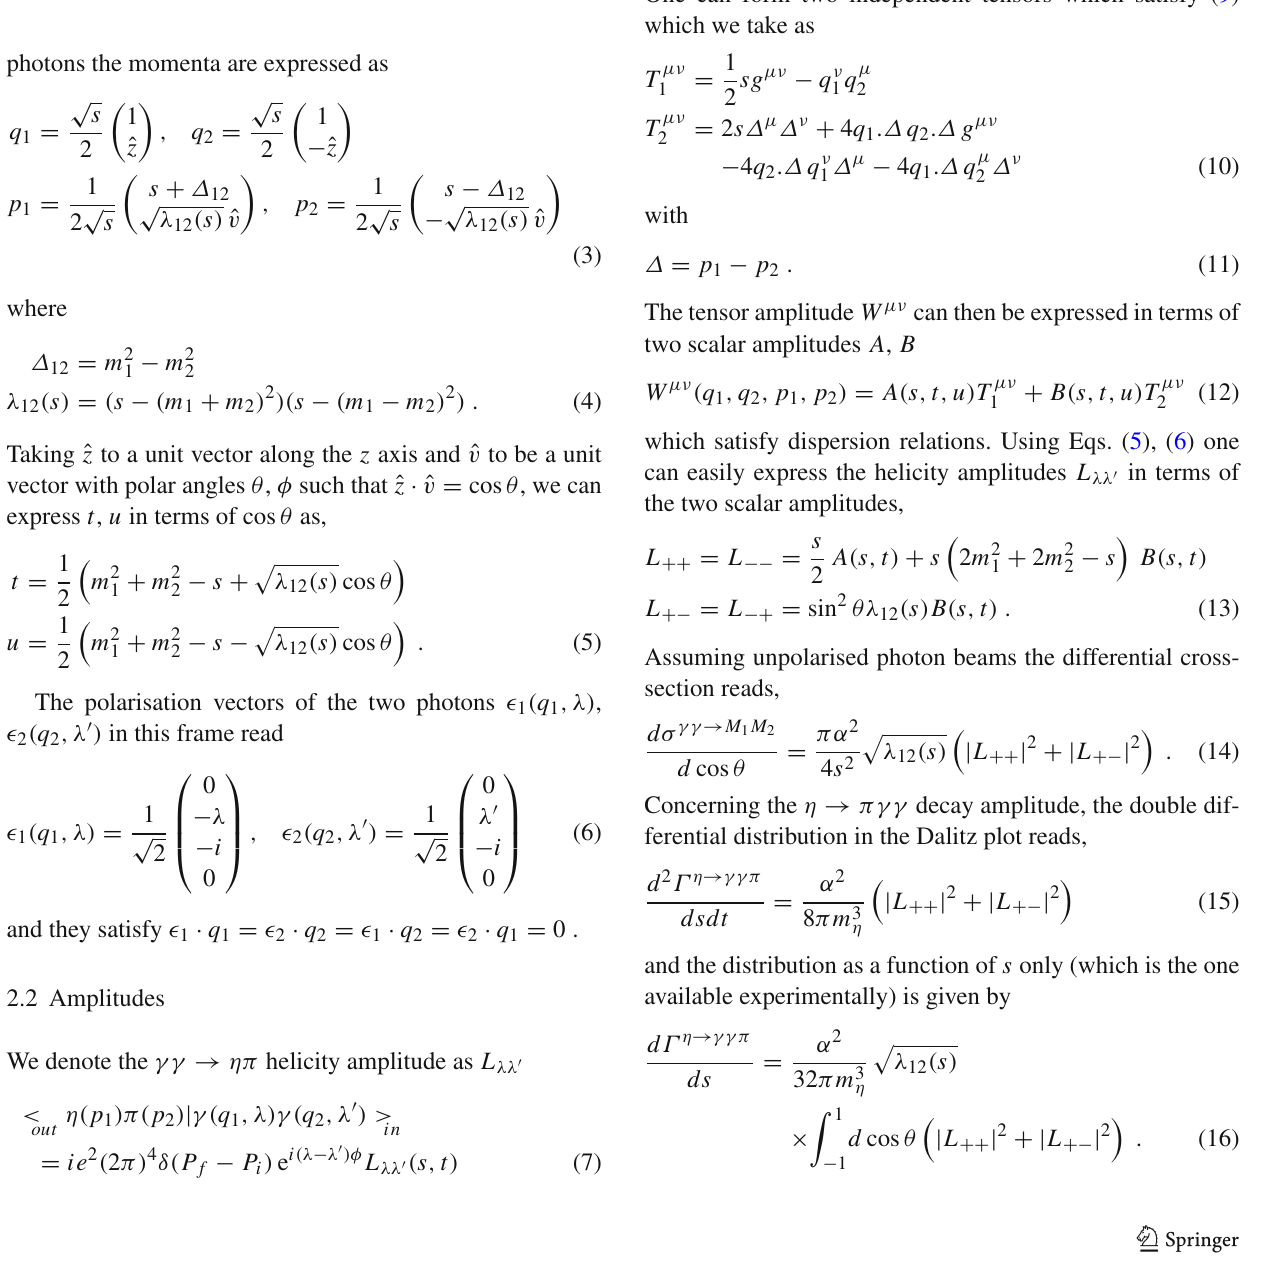
Fig. 1 Physical regions for γγ → πη , γπ → γη scattering and η → γγπ 0 decay. The black square indicates the soft pion